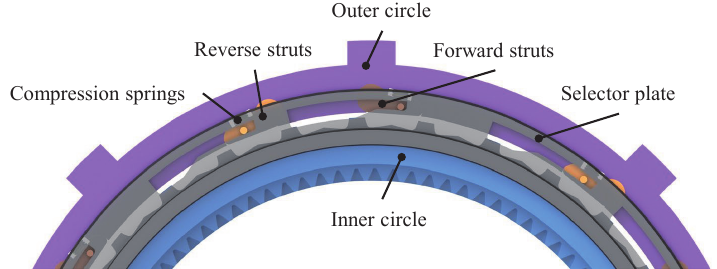
Figure 6. Schematic diagram of the second and neutral gears.